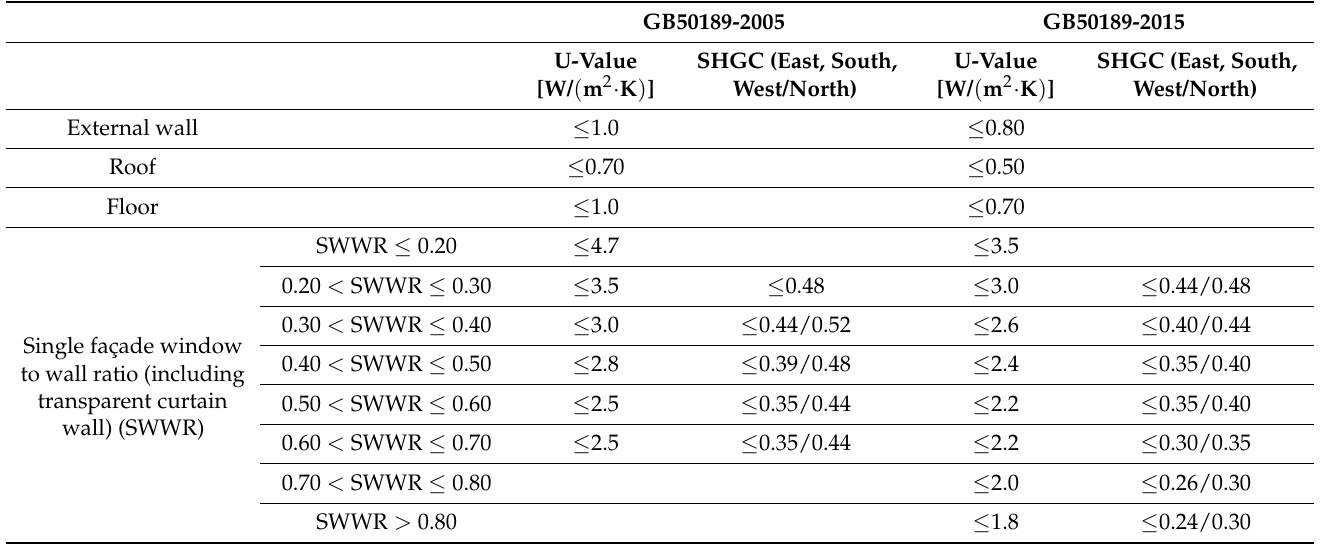
Table 1. Comparison of baseline values of building envelope thermal properties of GB50189-2005 and